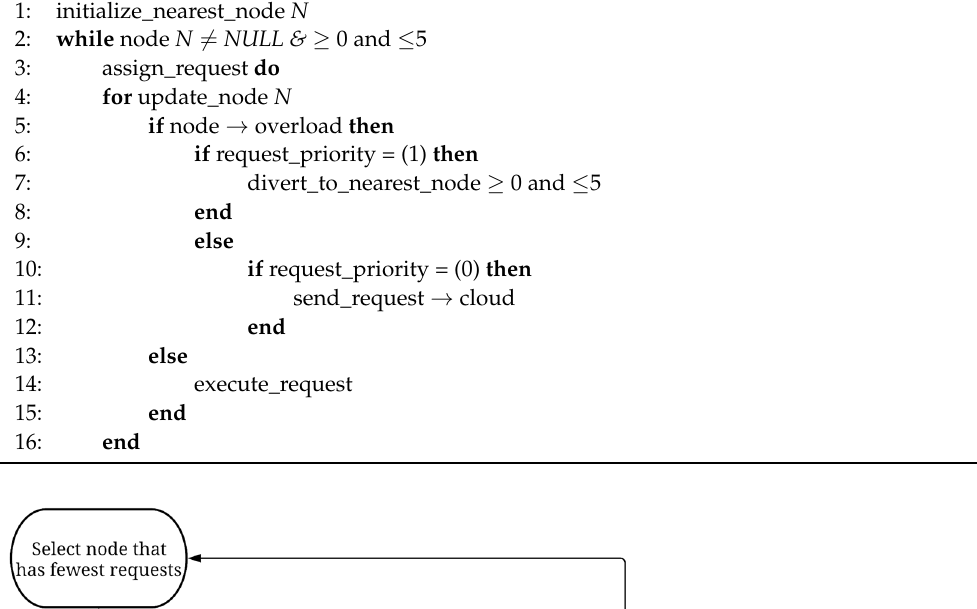
Algorithm 1 Request transmission pseudo-code